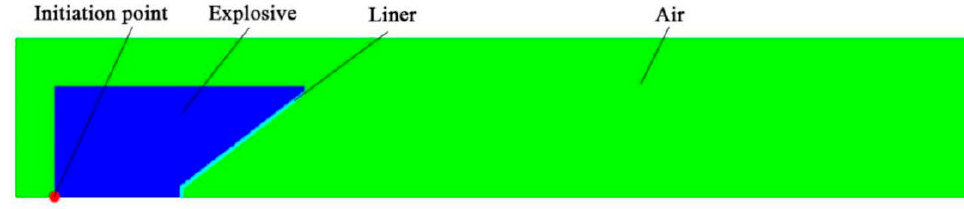
Figure 5. Computational simulation model. Table 1. Main material parameters of the numerical model.